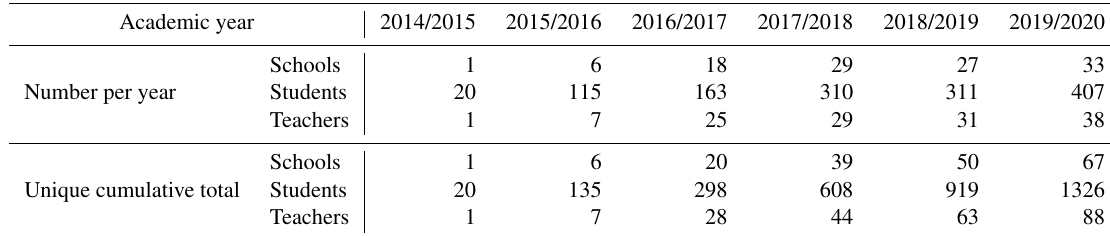
Figure 2. Photos of various stages of the PRiSE framework: students participating in an on-campus kick-off workshop (a) , students inter- acting during the poster session at a conference (b) , a group of students display their prizes won at a conference along with their teacher (c) , and a group presents a talk at a conference (d) . Table 2. Number of schools, students, and teachers involved in PRiSE by academic year as the programme has